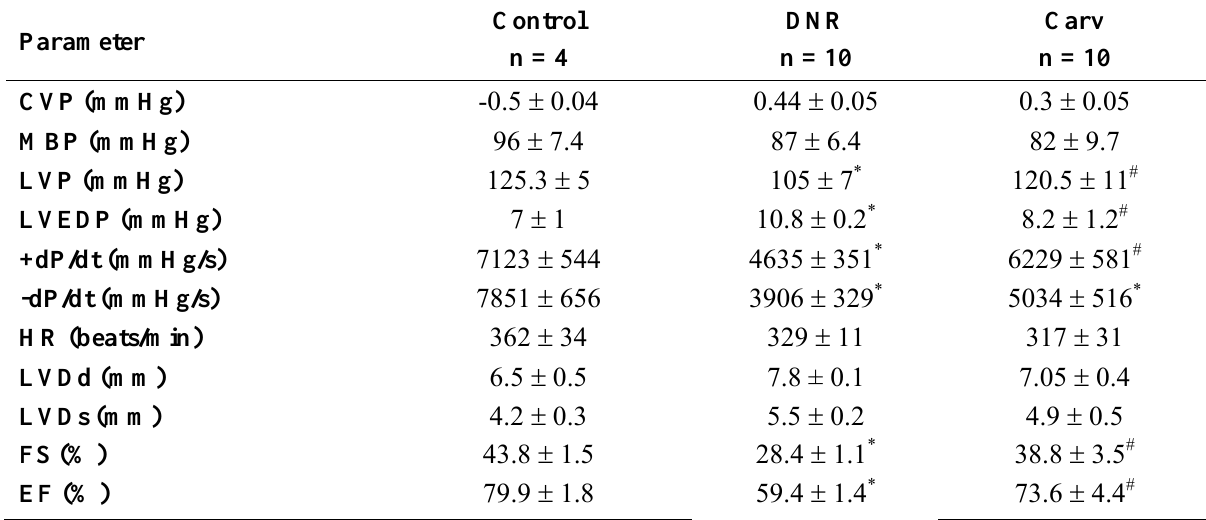
Table 3. Changes in hemodynamic, and echocardiographic parameters after 6 weeks of treatment with carvedilol in DNR